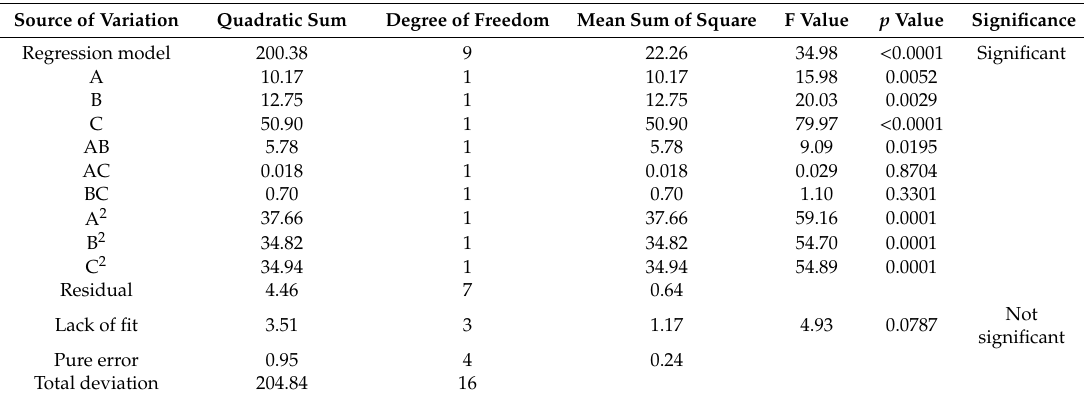
Table 3. Regression analysis